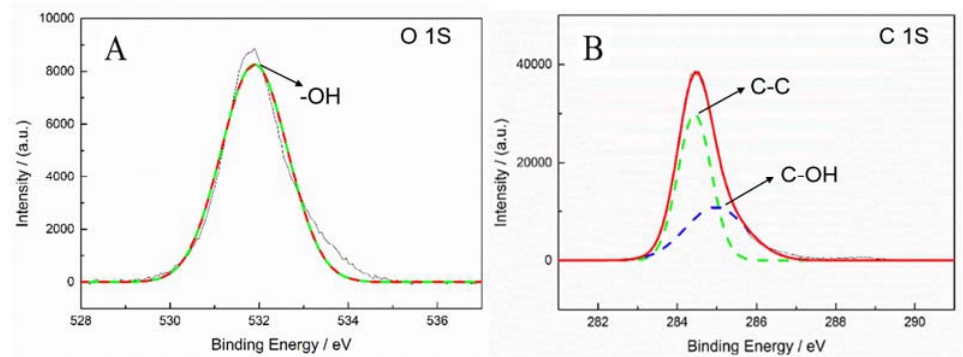
Figure 10. Fiber surface element analysis of XPS spectra of the fiber treated by method F-a. ( A ) O 1S, ( B ) C